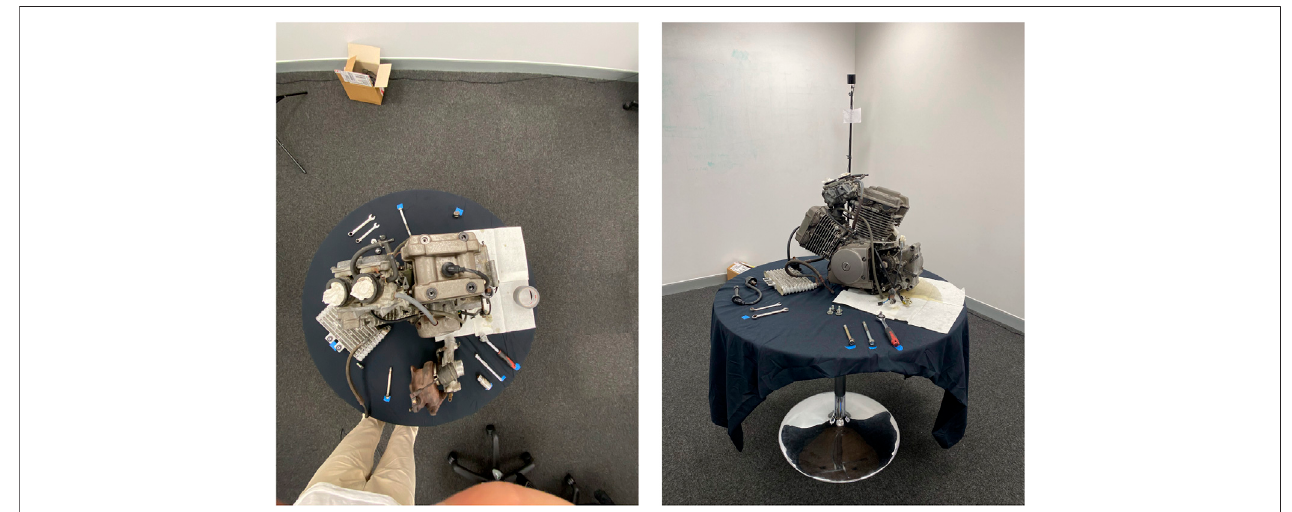
FIGURE 5 | Experiment setup: Layout of the tools and engine on the table before each condition.